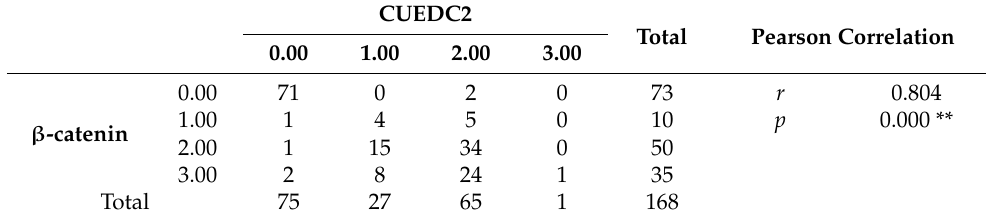
Table 1. Correlation of CUEDC2 and β -catenin protein levels in TNBC tumor tissues. CUEDC2 Total Pearson Correlation 0.00